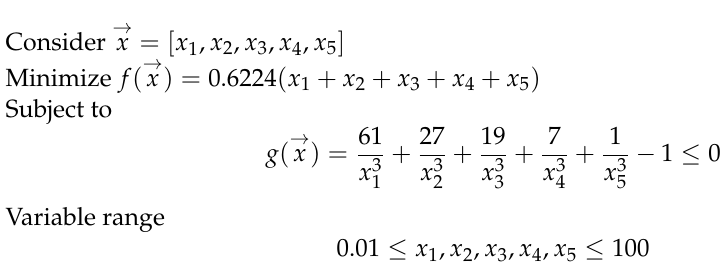
Figure 12. Schematic illustration of cantilever beam design problem.